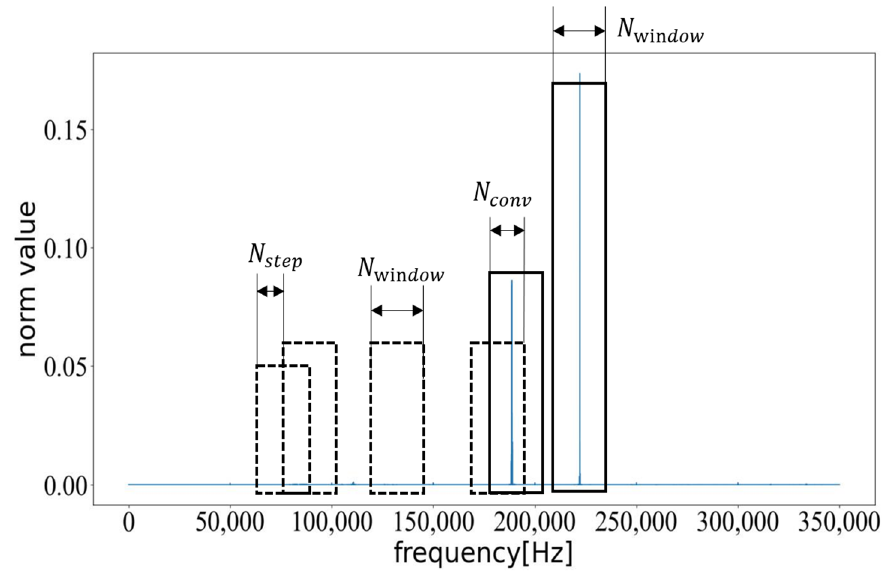
Figure 5. The defines of the sliding windows.